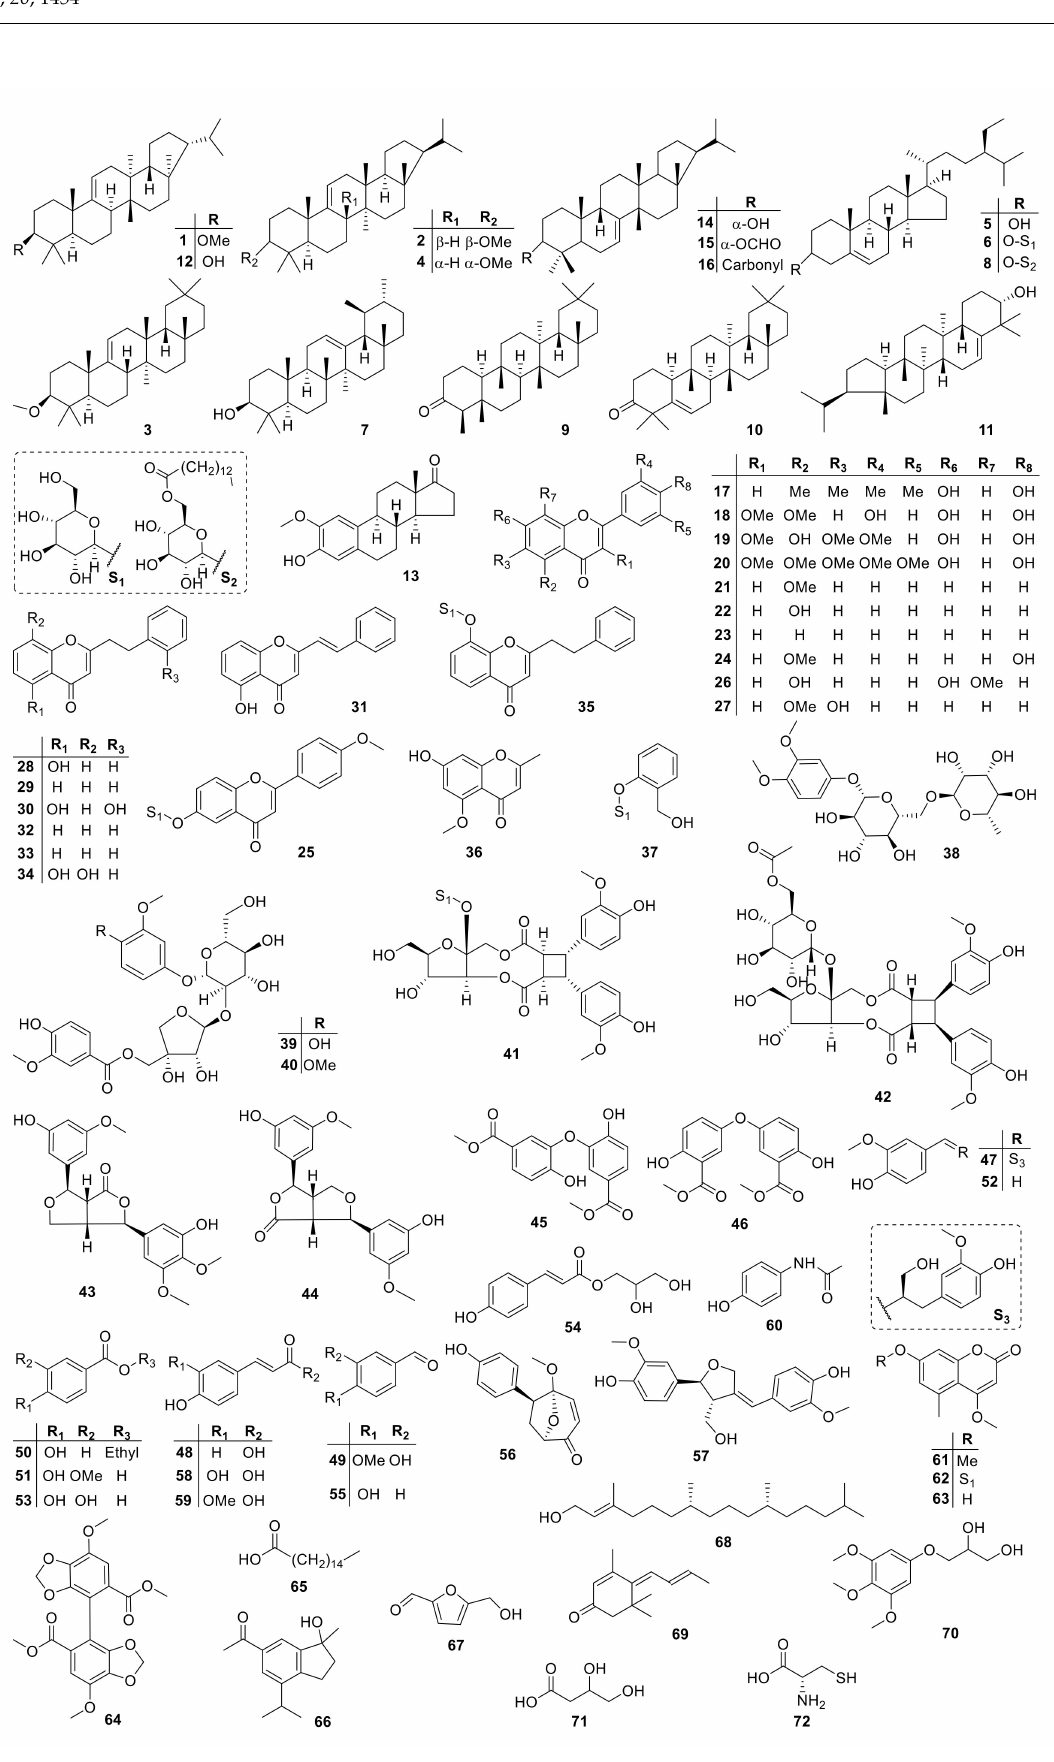
Figure 1. Constituents isolated from I.